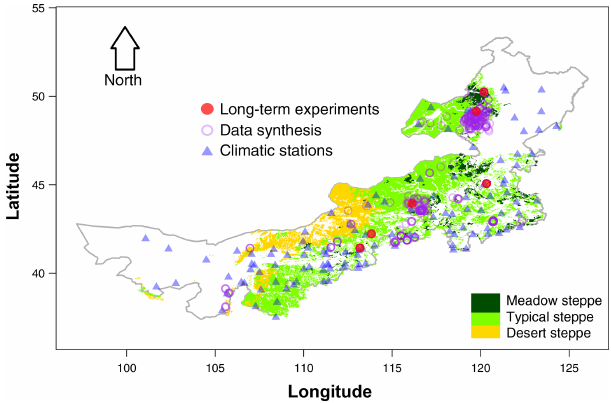
Figure 1. Spatial distribution of grassland aboveground biomass ob- servations and climatic stations in Inner Mongolia. The Inner Mon- golian grasslands are grouped into three categories (i.e. meadow steppe, typical steppe and desert steppe). Observations of grass- land biomass were both derived from the six long-term experimen- tal sites and data synthesis of existing studies. The ground climatic records were obtained from the National Meteorological Informa- tion Centre (NMIC) of